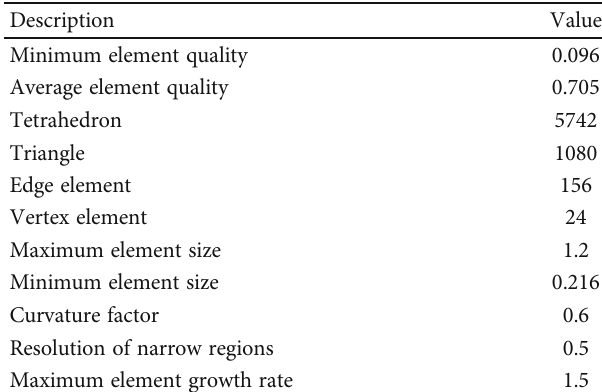
Figure 7: Three-dimensional geometry of the interelectrode capacitance fi lled with oil.